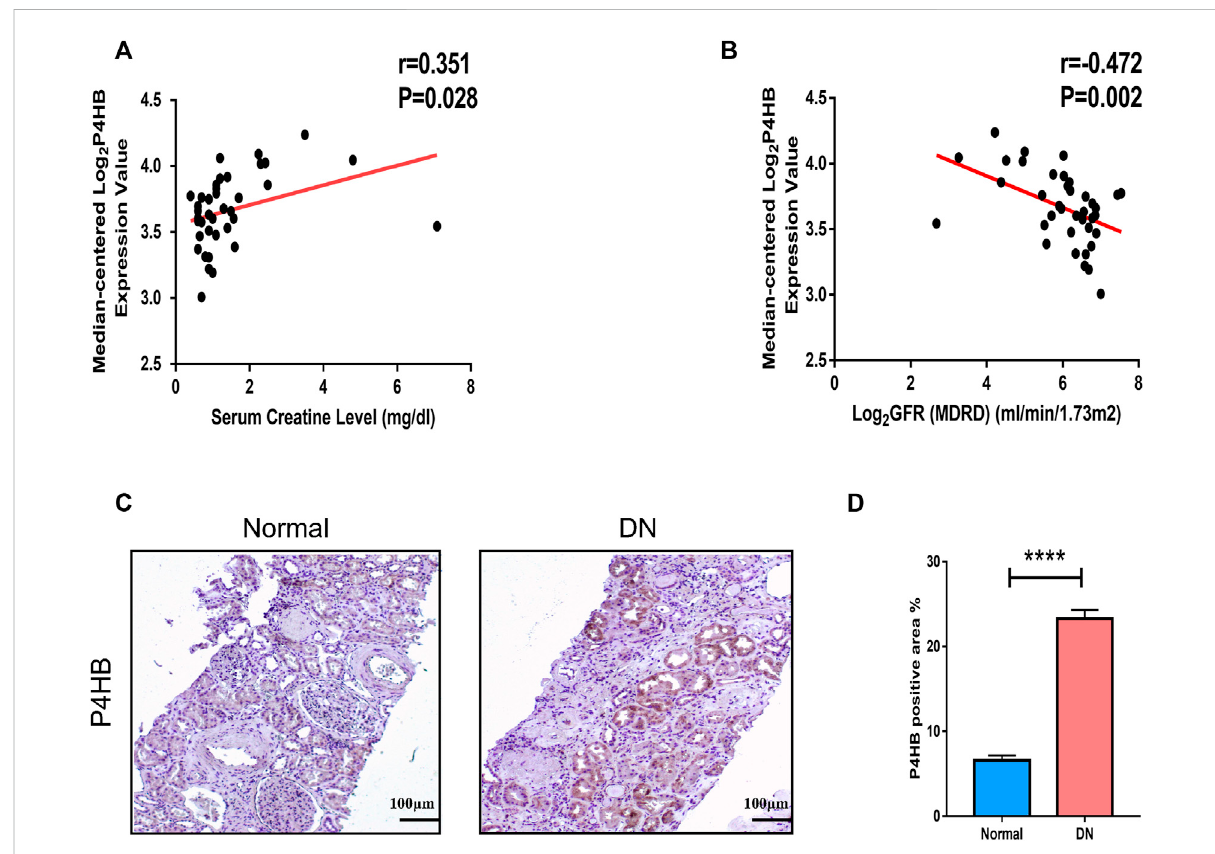
FIGURE 6 Clinical relevance of P4HB and immunohistochemical validation of P4HB expression. (A) Relevance of the expression of P4HB and serum creatinine level. (B) Relevance of the expression of P4HB and GFR. (C,D) Typical images and statistical charts of immunohistochemical staining of P4HB in normal renal tissues and DN renal tissues. Scale bars, 100 μ m. Results are expressedas the mean ± SEM. * p < 0.05; ** p < 0.01; *** p < 0.001, and **** p < 0.0001. GFR, glomerular fi ltration rate; DN, diabetic nephropathy; SEM, standard error of the